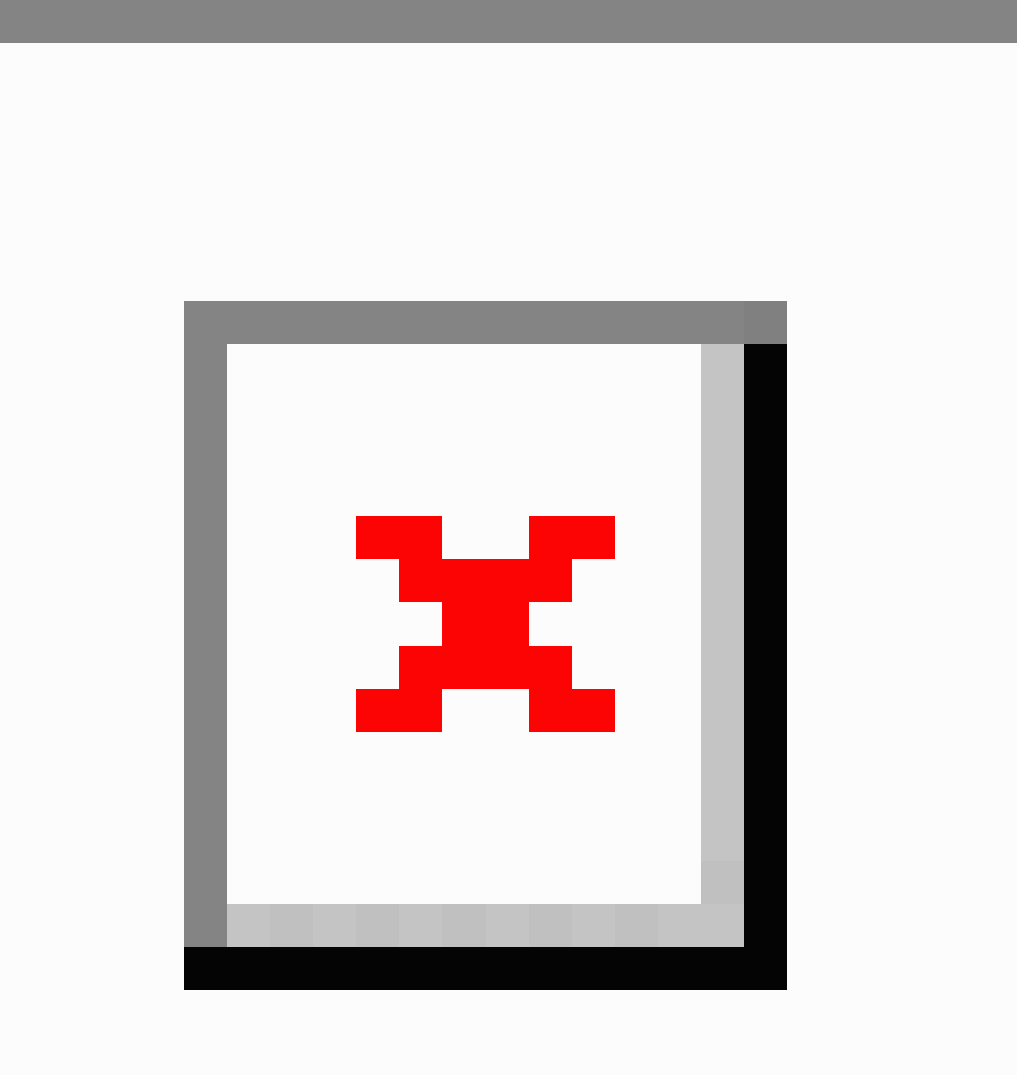
Figure 5. How knowledge is exchanged in Mobile Exchange of Knowledge (MEK) [22], where is information about user’s profile, <ack> is acknowledge and <k>is a piece of